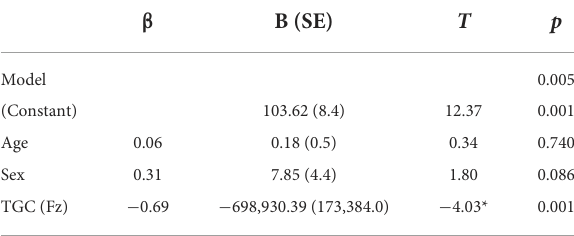
TABLE 3 Linear regression analyses were performed with SVAQ OE as the dependent variable and age, sex, and TGC as independent